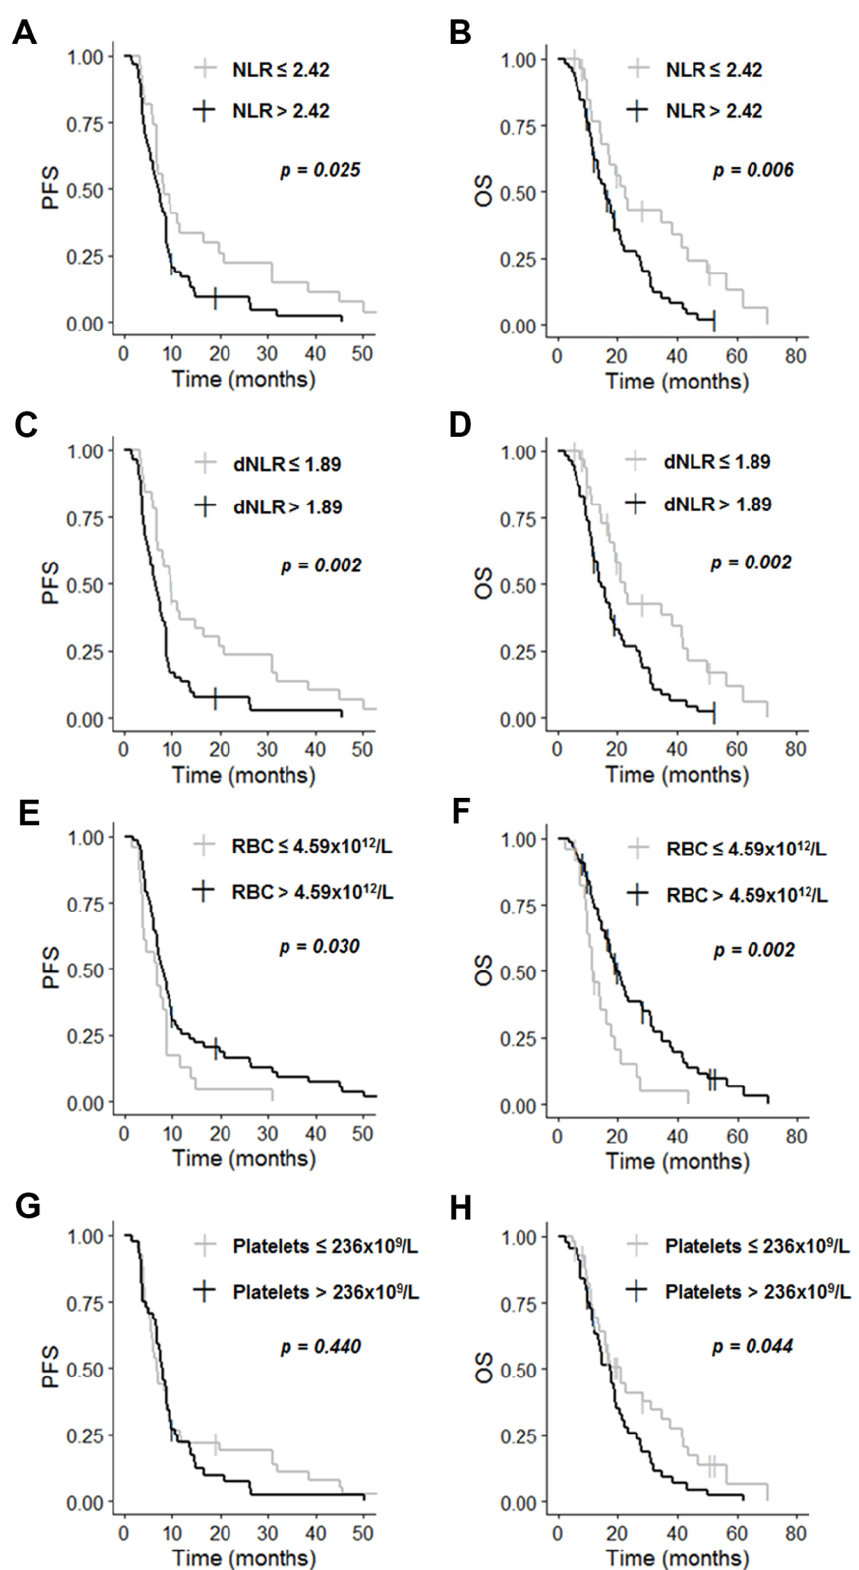
Figure 1. Kaplan–Meier curves for survival stratified by NLR (( A ) PFS; ( B ) OS), dNLR (( C ) PFS, ( D ) OS), RBC (( E ) PFS; ( F ) OS) and platelets (( G ) PFS; ( H ) OS). Abbreviations: dNLR, derived neutrophil-to-lymphocyte ratio, NLR, neutrophil-to-lymphocyte ratio; OS, overall survival; PFS, progression-free survival; RBC, red blood cells.